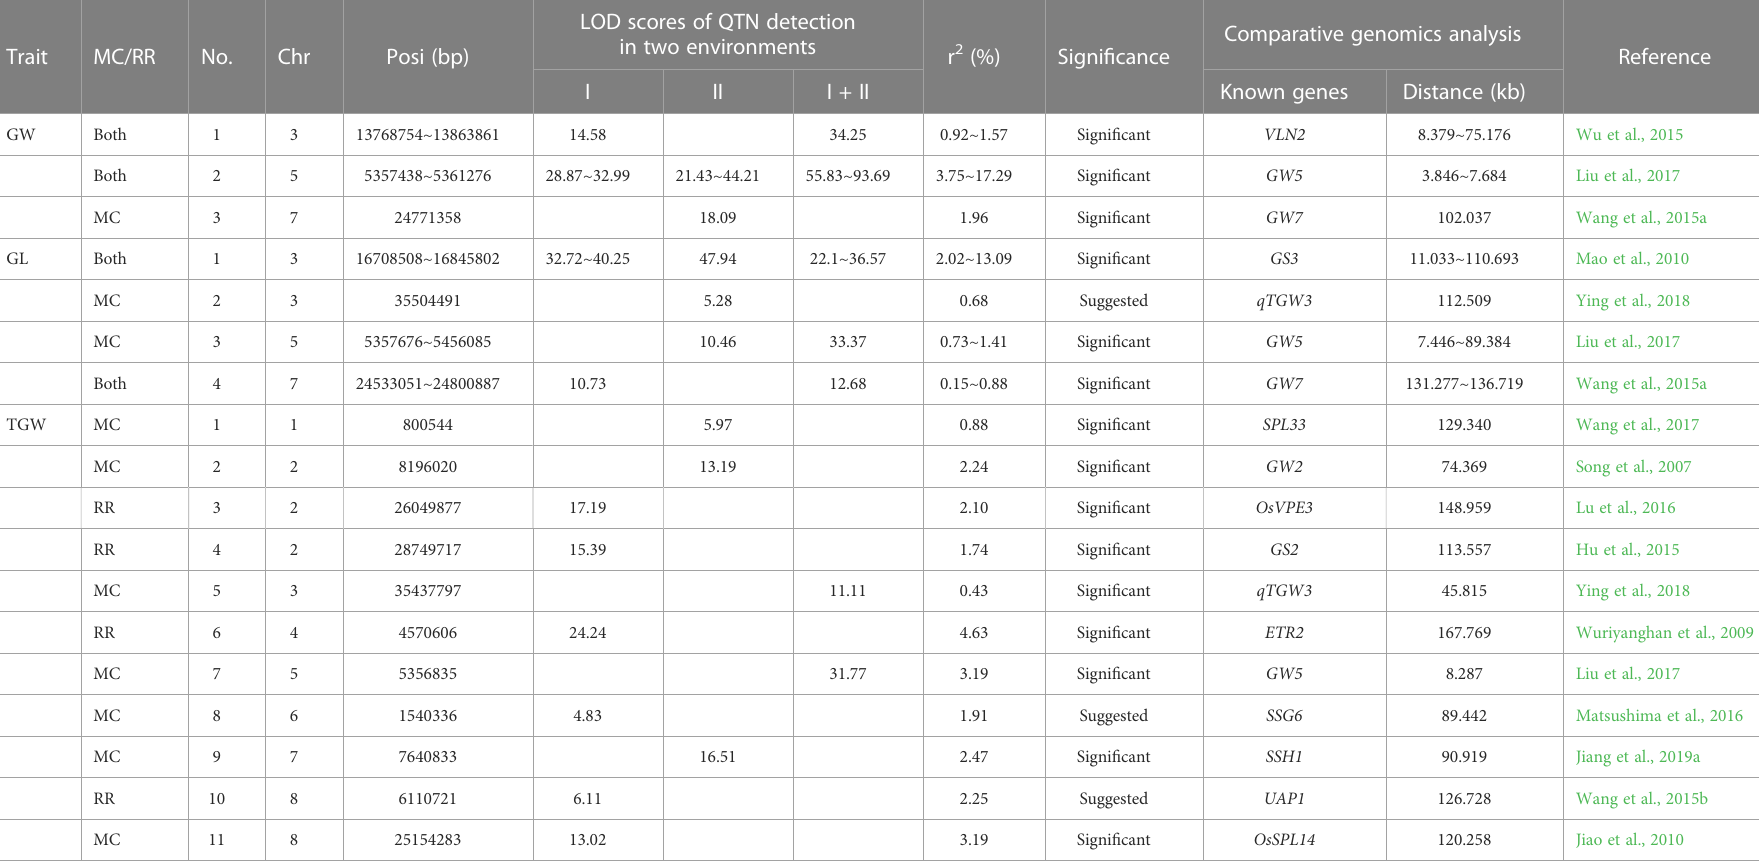
TABLE 1 Known genes around QTNs for grain length (GL), grain width (GW), and thousand grain weight (TGW) in main crop (MC) and ratoon rice (RR).